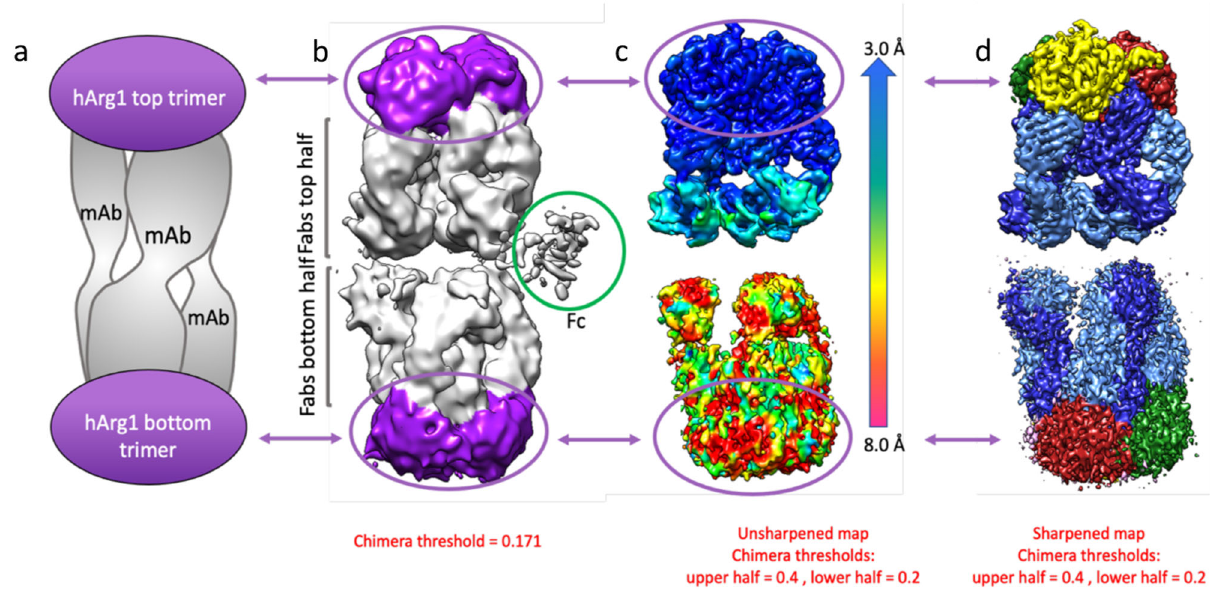
Fig. 1 Simple depiction and cryo-electron microscopy maps of the 2:3 hArg1:mAb1 complex. a Most complexes presented in this paper consist of two hArg1 trimers on the top and bottom of the complex spanned by three full mAbs, giving the complex a sandwich-like appearance. b An exemplar map for the hArg1:antibody structures described in this paper, colored to match the fi rst image. c A color shell based on local resolution is overlaid with an unsharpened map. It is apparent that the more highly-resolved top half of the complex is almost completely within the 3 – 4 Å range. It is likely that the bottom half is just as ordered, but its fl exibility relative to the top half results in the seeming loss of resolution. The top half of each complex was used to map epitope and paratope interactions. d A sharpened map of the